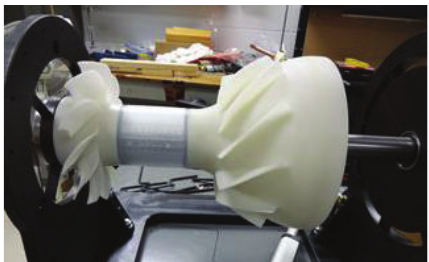
Figure4:Low-speedaxial-mixedcompressortestrigwithoutcasing showing axial and mixed flow